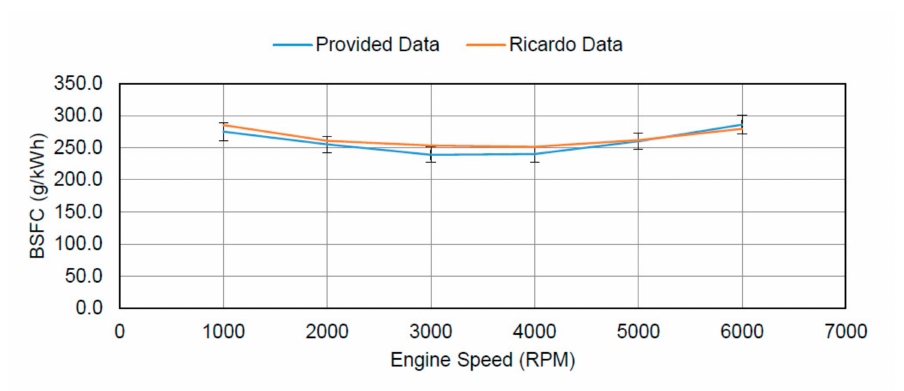
Figure 14. Comparison between provided engine power and Ricardo WAVE model.